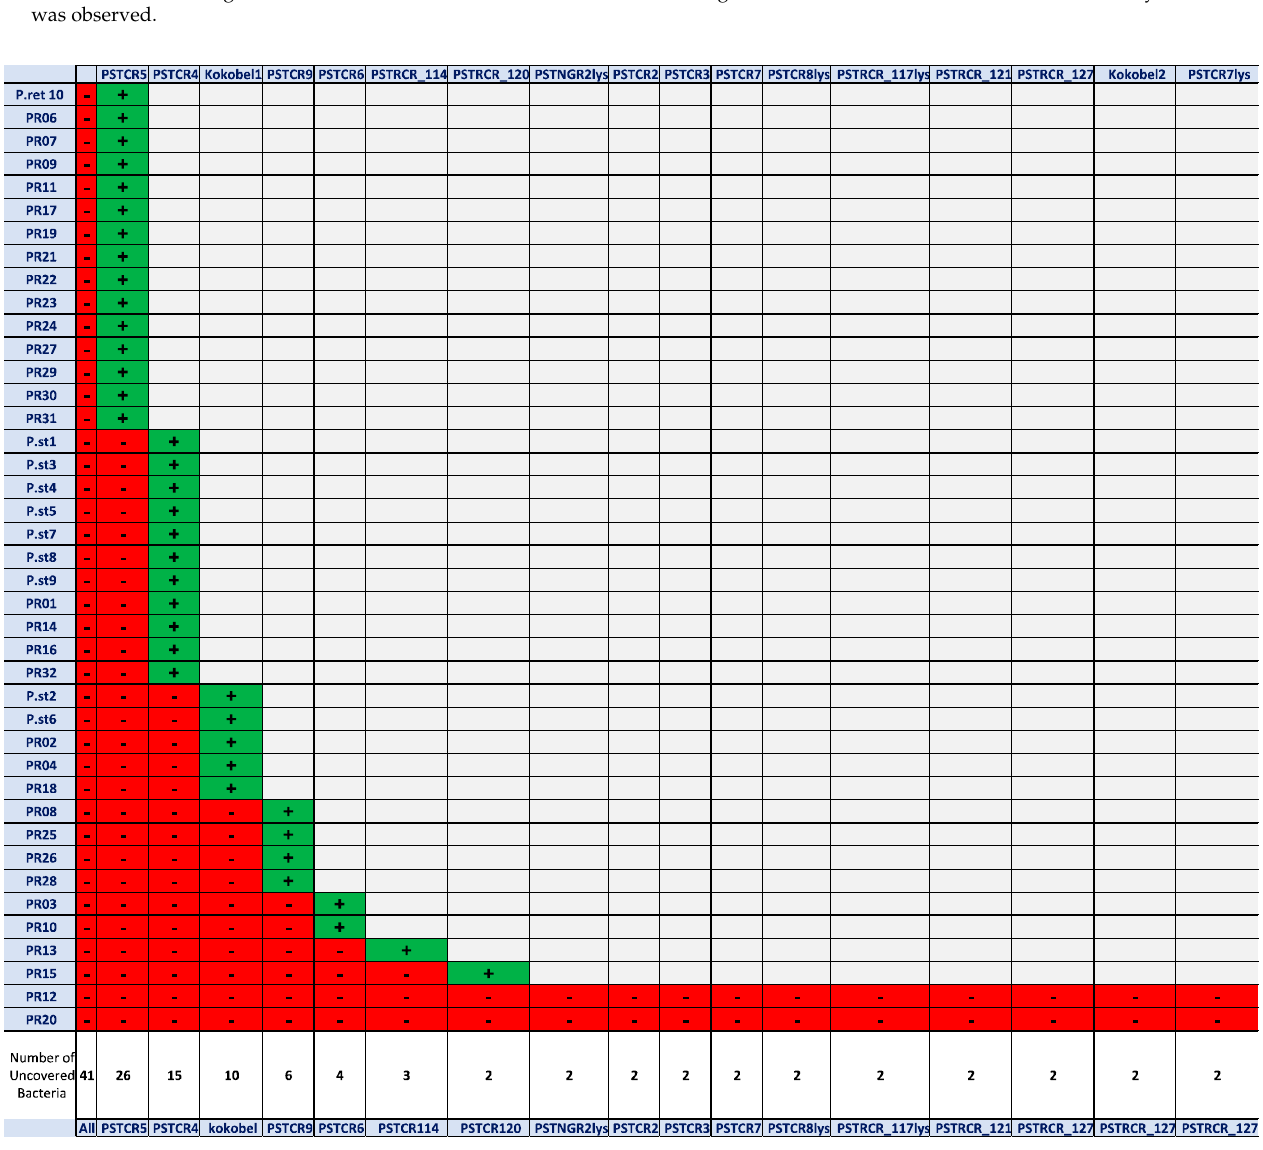
Figure 1. Reduction screen. The bacterial isolates killed by each noted phage (green), and those that remained for the next screen (red) after phage exposure.